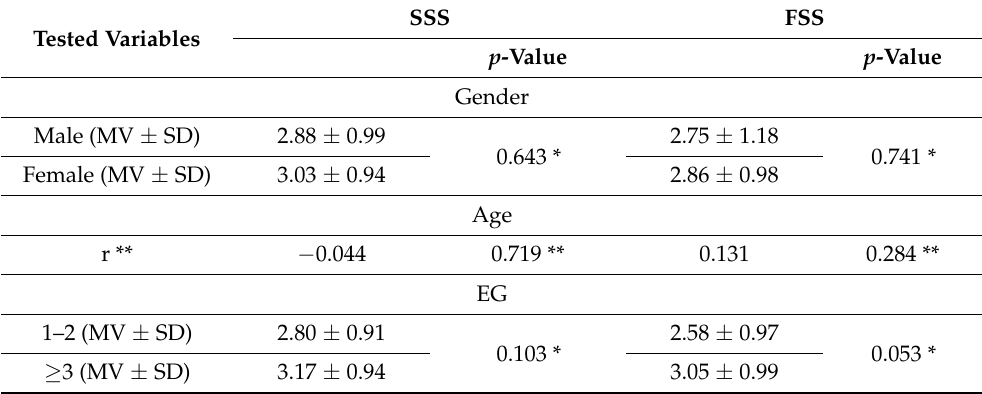
MV—Mean value; SD—Standard deviation; SSS—Symptom severity subscale; FSS—Functional status subscale; EG—Electrophysiological grading; * Independent sample test; ** Pearson correlation coefficient. A ROC curve analysis demonstrated that for the SSS, the cut-off value was 3.32, with a sensitivity of 53.8%, a specificity of 70% and an AUC of 0.603 ( p = 0.146). For the FSS, the cut-off value was 3.06, with a sensitivity of 56.4%, a specificity of 70% and an AUC of 0.644 ( p = 0.042) (Figure 3).